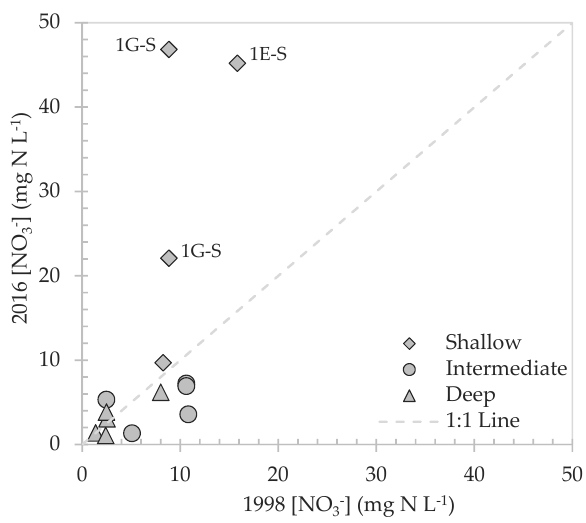
Figure 4. Comparison of nitrate concentrations from five well nests sampled in 2016 and 1998 ( n = 14). Labels indicate the three wells with high 2016 [NO 3 − ].